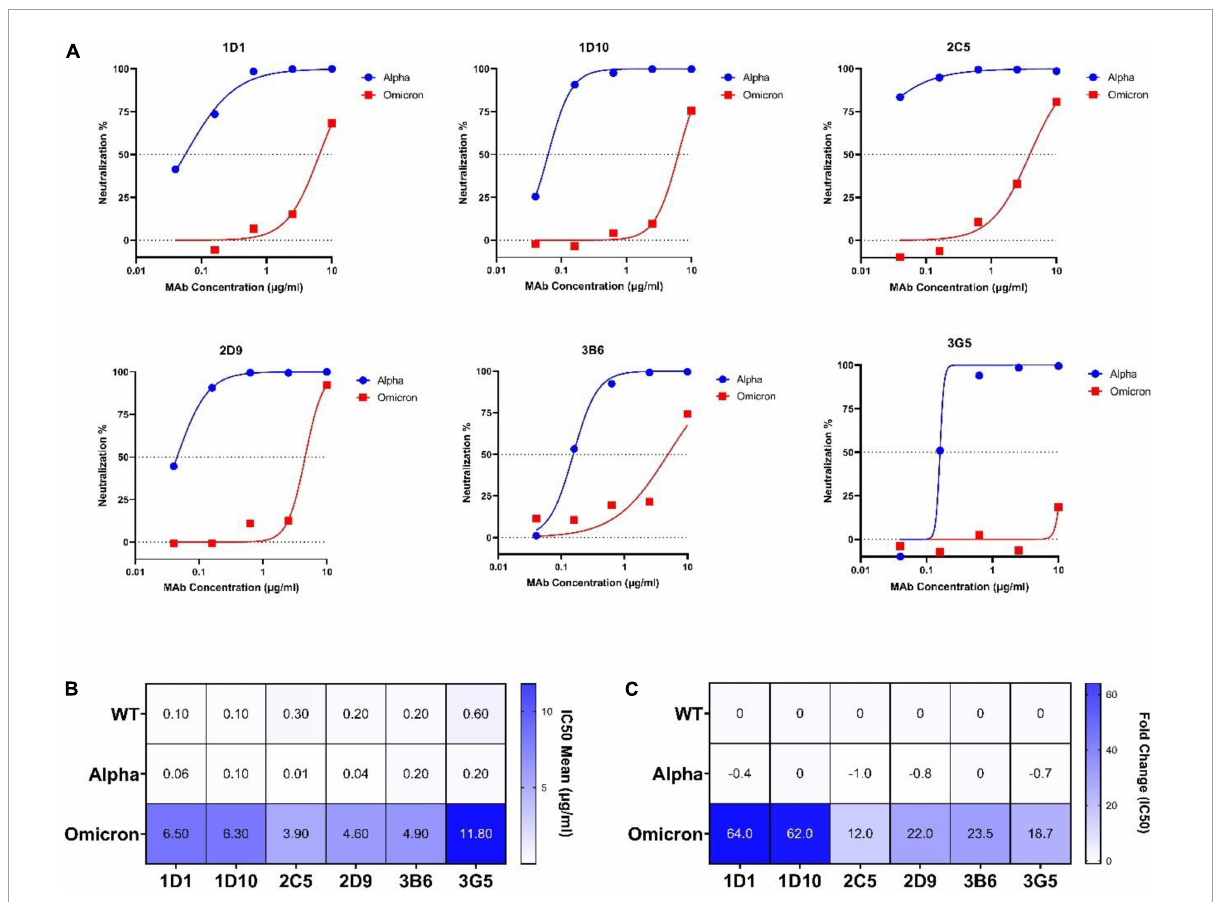
FIGURE7 Neutralization potency of selected MAbs against alpha and omicron variants. (A) Dose-response curves and IC50 values of selected MAbs at different concentrations (0.04, 0.16, 0.63, 2.5, and 10 µ g/ml) against alpha and omicron variants determined by CVNT. The dotted lines on each graph indicate 0 and 50% neutralization. The IC50 was calculated by non-linear regression (four-parameter), as represented in (B) . (B) Heatmap of IC50 mean values of selected MAbs against WT (wild-type), alpha, and omicron viruses. (C) Heatmap of calculated IC50 fold changes of selected MAbs against alpha and omicron variant obtained from CVNT based on IC50 values against WT virus. The increase or decrease in IC50 values relative to WT is shown as positive or negative fold change values, respectively. CVNT, conventional virus-neutralizing test; IC50, inhibition concentration 50%; MAb, monoclonal antibody; VOC, variant of